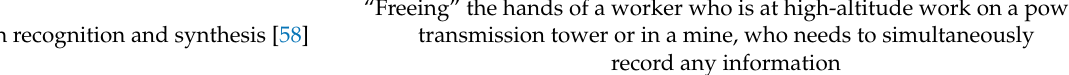
Key element of automated integration of control